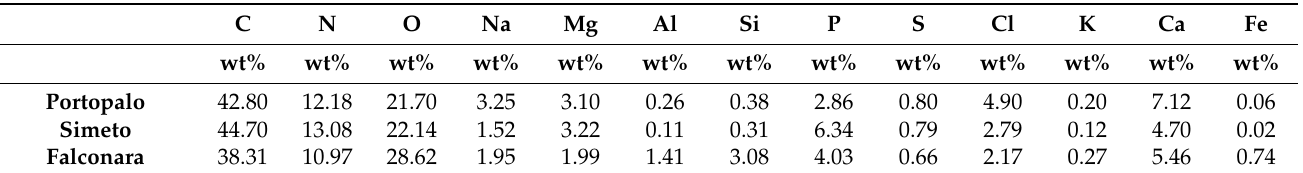
Table 1. Average chemical compositions (weight percentage—wt%) of the analyzed biocement from the Portopalo, Simeto, and Falconara samples.